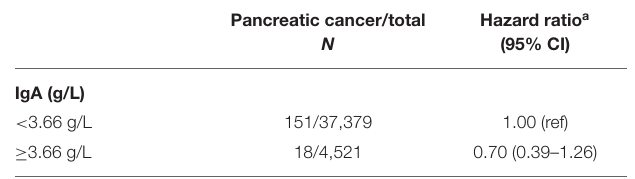
TABLE 6 | Hazard ratio (HR) for risk of pancreatic cancer, in the study population with a measurement of IgA, with 95% confidence intervals (CI) using Cox proportional hazards